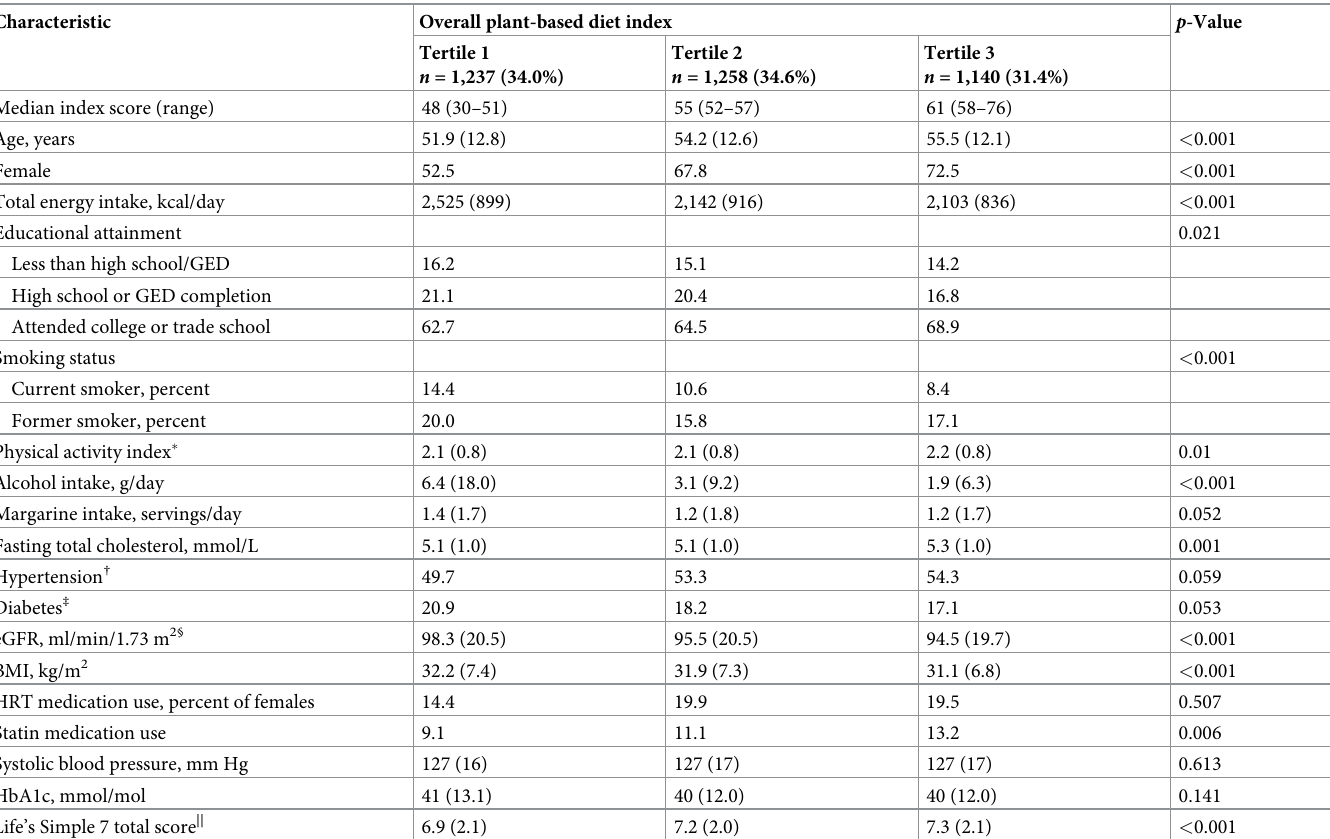
Table 1. Selected baseline demographic, socioeconomic, and health characteristics by tertiles of plant-based diet index in the Jackson Heart Study.